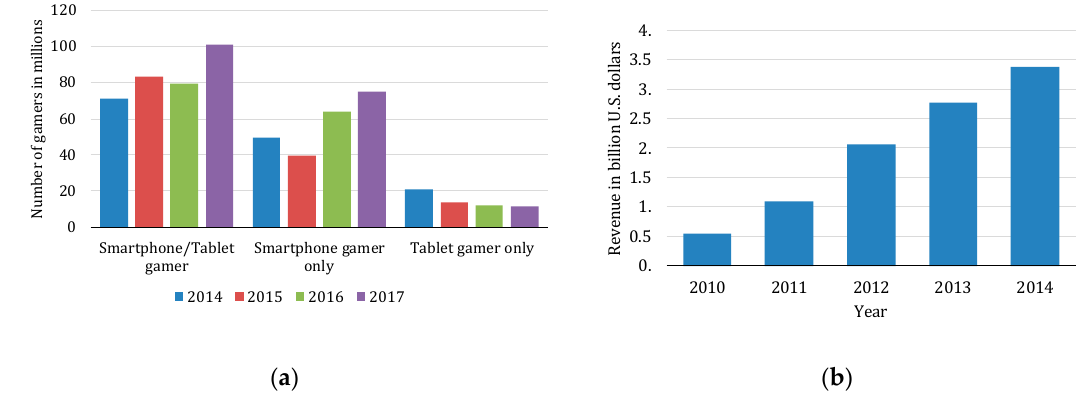
Figure 2. Trends of mobility: ( a ) number of mobile gamers in North America from 2014 to 2017; ( b ) worldwide mobile social gaming revenue from 2010 to 2014.